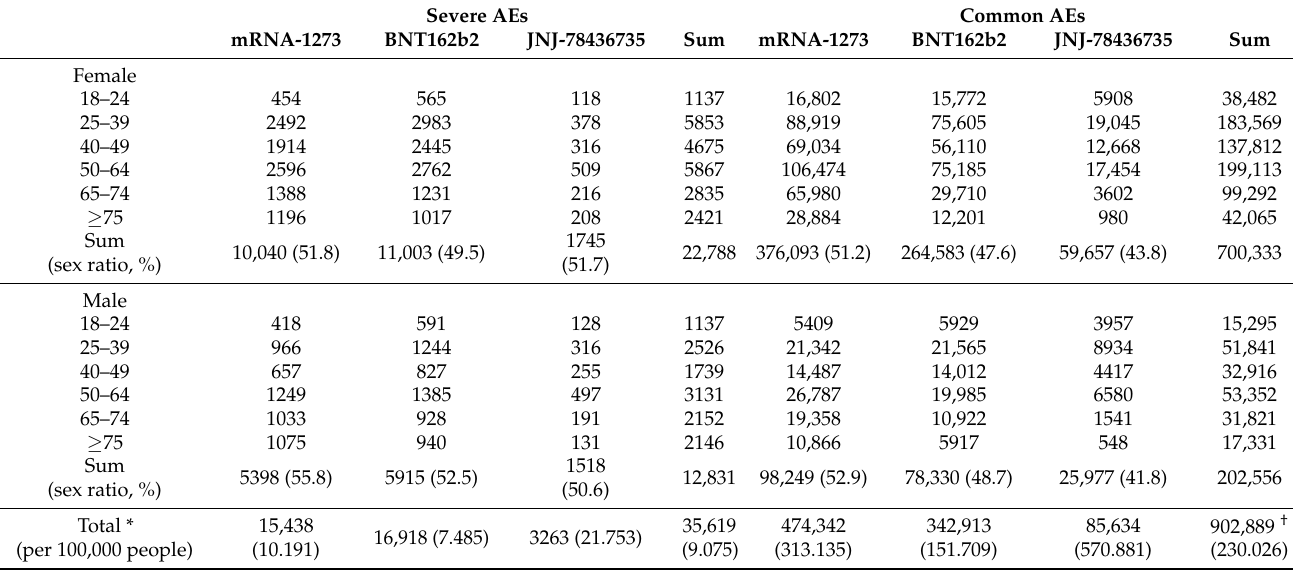
Table 1. Demographic characteristics of individual cases with specific AEs among recipients of one of the two mRNA vaccines (BNT162b2, Pfizer-BioNTech; and mRNA-1273, Moderna) or one viral vector vaccine (JNJ-78436735, Janssen/Johnson and